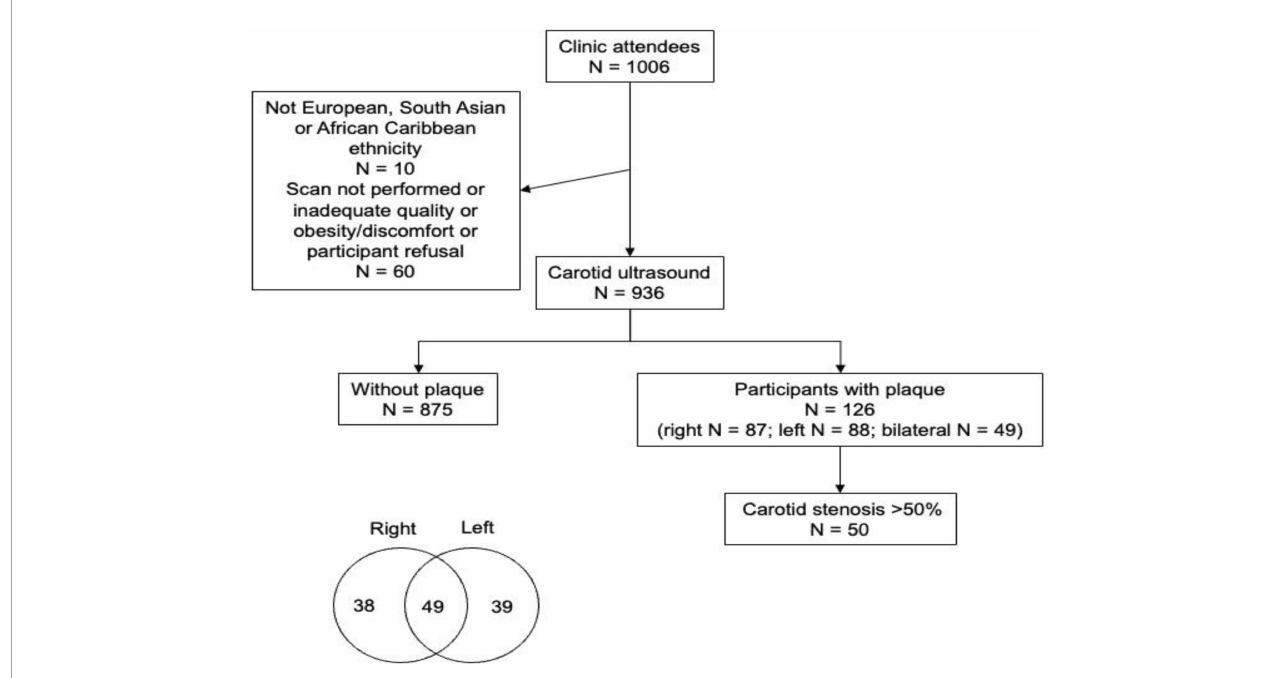
FIGURE1 Diagram of participant flow including location of plaques as a Venn